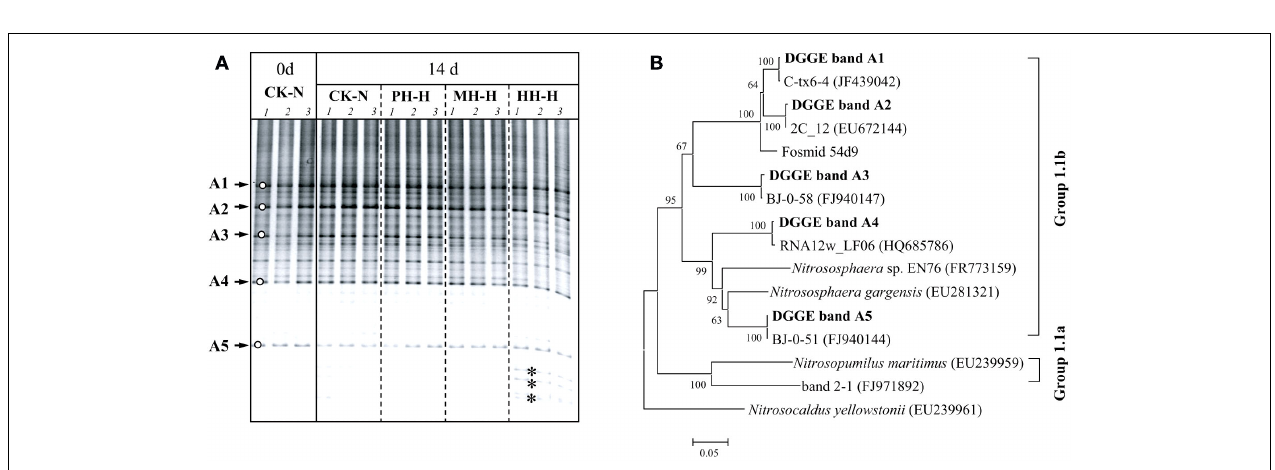
FIGURE 3 | Denaturing gradient gel electrophoresis fingerprints (A) and phylogenetic tree (B) of bacterial amoA gene in soil microcosms.